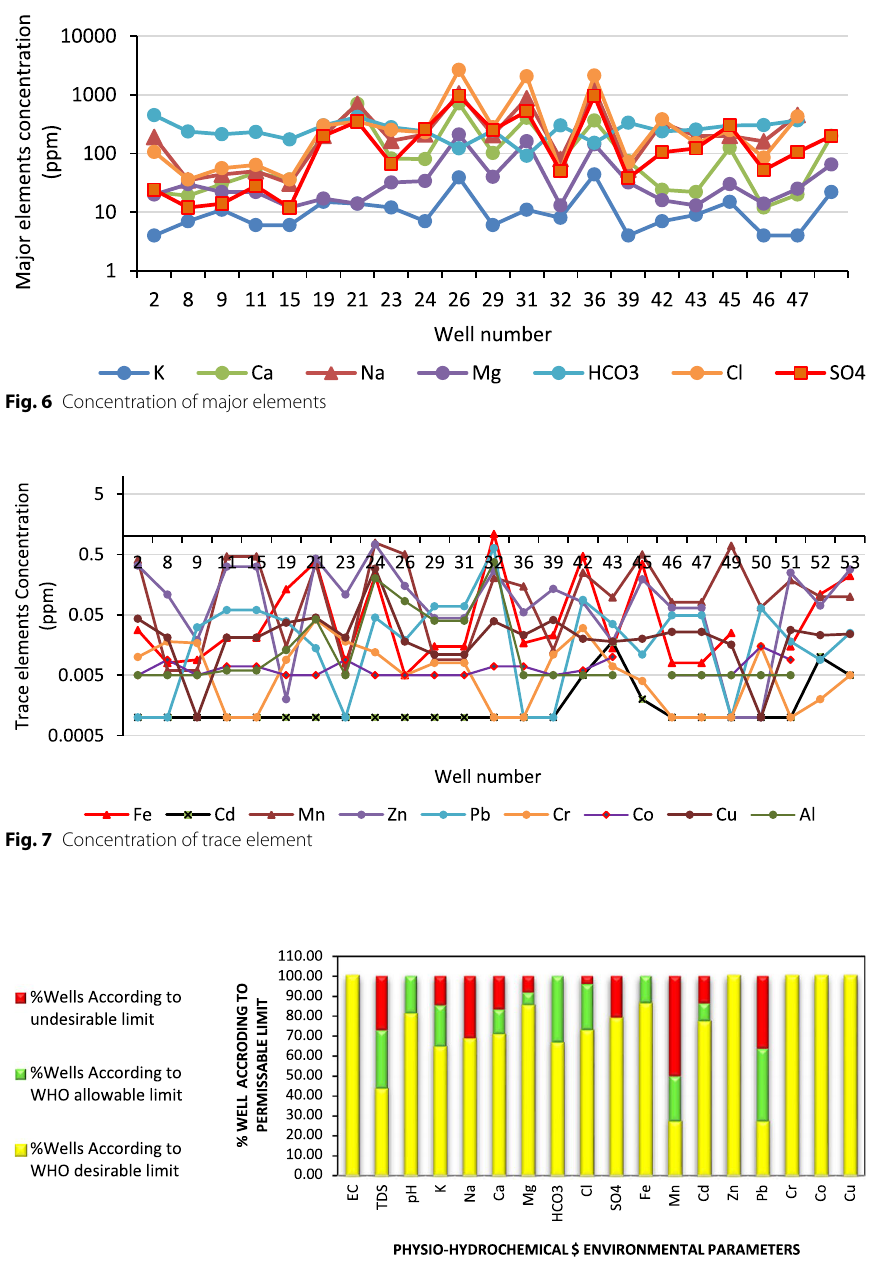
Fig. 8 Concentration for 20 elements by percentage of wells (relevant to their limits of WHO for each